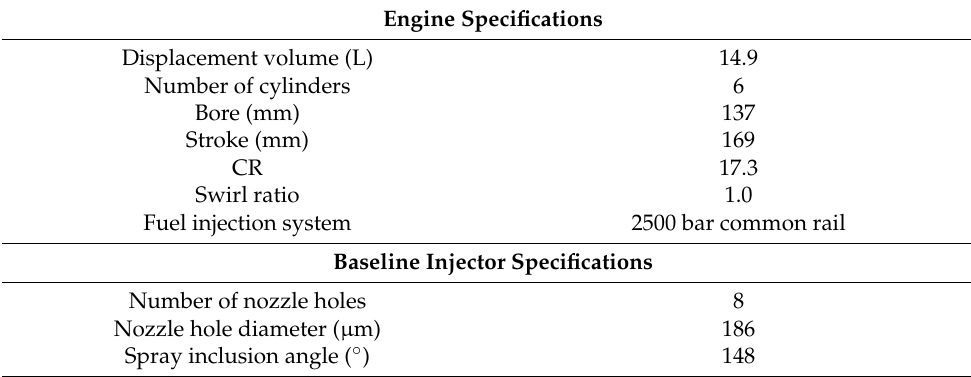
Table 1. Engine and fuel injector specifications.